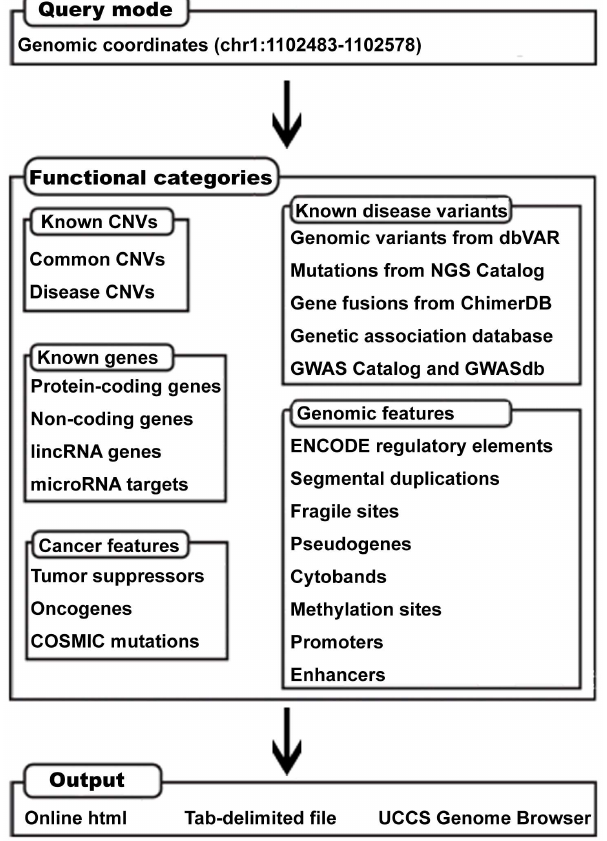
Figure 1. The input, annotation categories, and output of